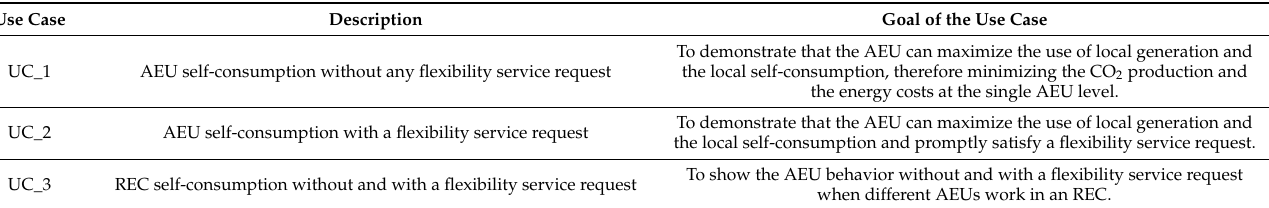
Table 1. Experimental Use